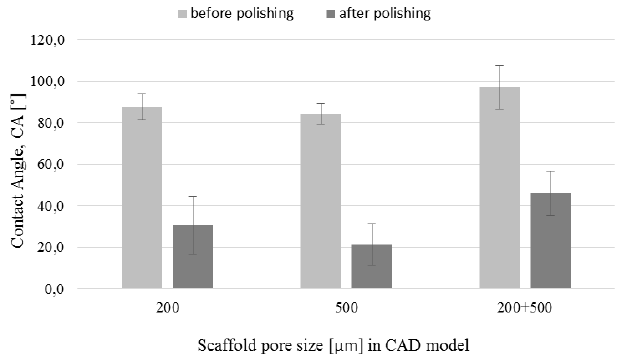
Figure 8. Change of water contact angle after chemical polishing.